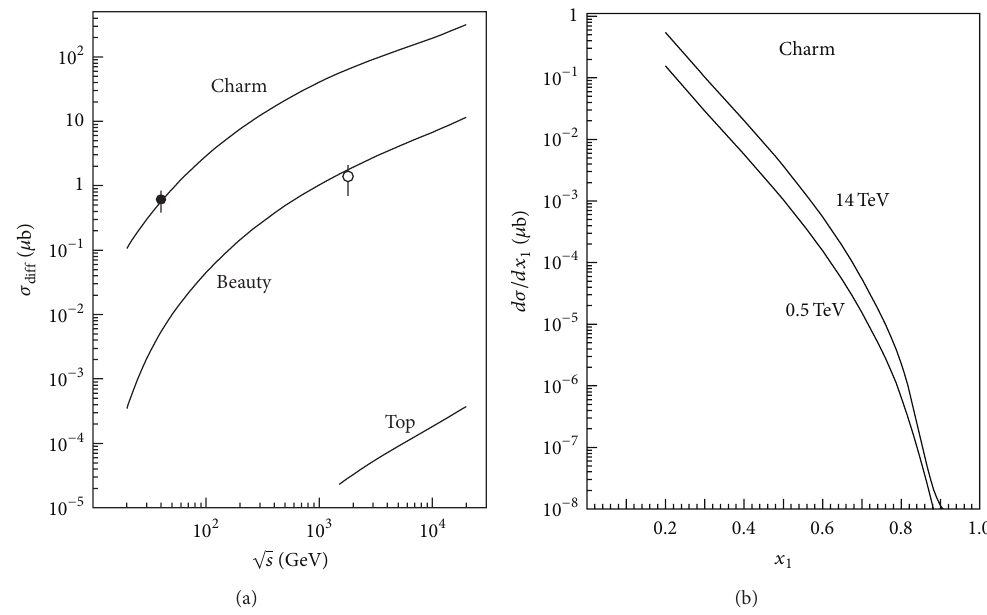
Figure 14: The total cross section of diffractive 𝑐𝑐 , 𝑏𝑏 , and 𝑡𝑡 pairs production as function of energy in comparison with experimental data from E690 [27] and CDF [28] experiments (a) and the differential cross section as function of fraction 𝑥 1 of the initial proton momentum carried by the charm quark (b) [9].